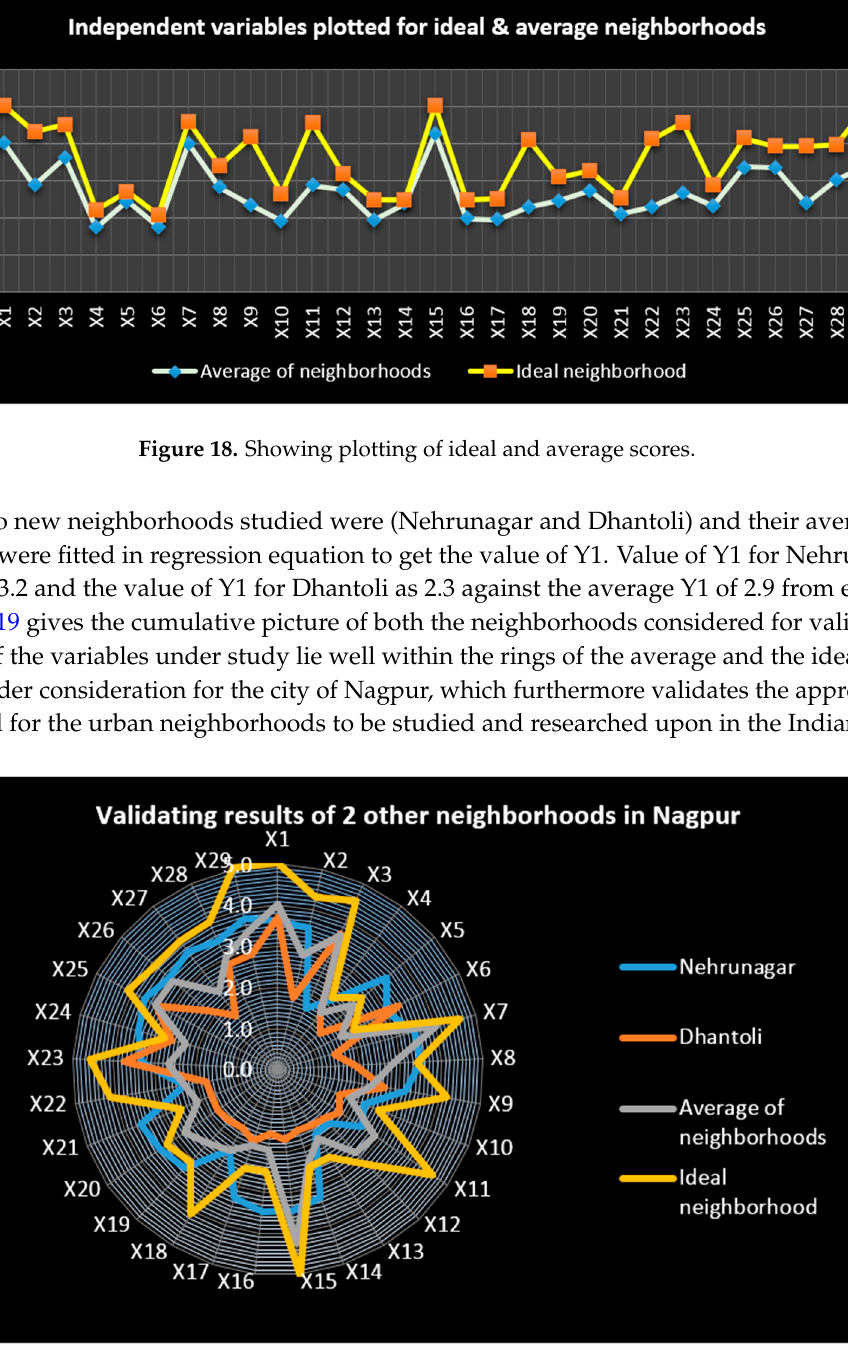
Figure 17. Average Scores of variables plotted against the respective neighborhoods.